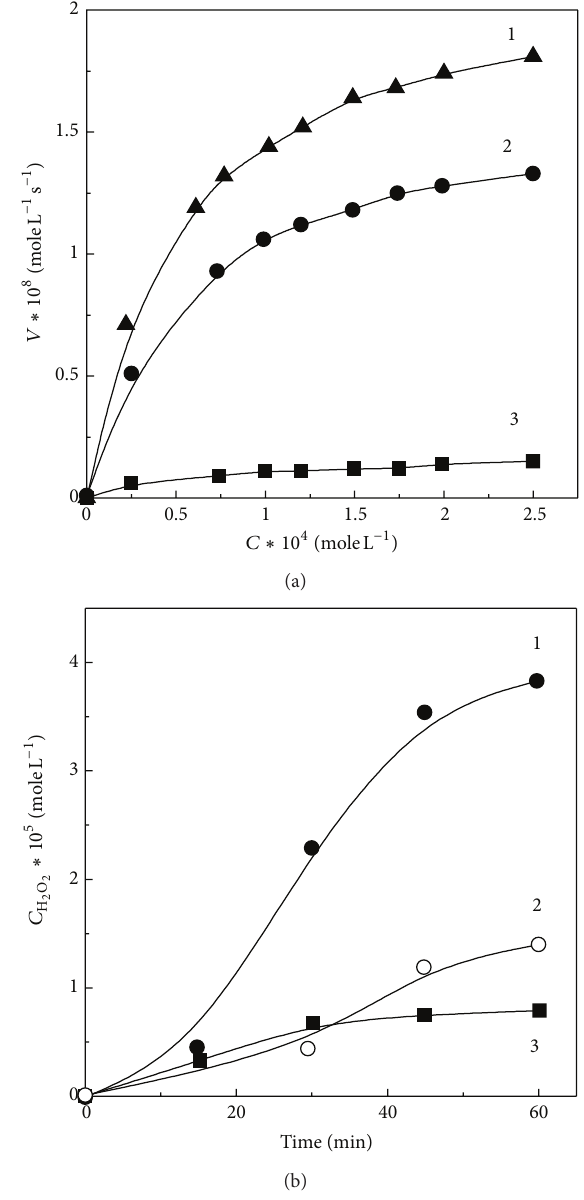
Figure 5: Thedependence oftheinitialvelocity ( 𝑉 )ofDCPAphoto- catalytic oxidation by atmospheric oxygen on initial concentration of the DCPA ( 𝐶 ) in the aqueous suspensions Fe 2 O 3 (0,5wt.%)— TiO 2 (1), TiO 2 (2), and Fe 2 O 3 (3) a composite system based on in water (pH 4.5) (a); photo generation of H 2 O 2 in aqueous suspension Fe 2 O 3 (1wt%)—TiO 2 , (1g 𝜇 M −3 ) in an oxygen atmosphere under UV light (high-pressure mercury UV lamp SVD-120, 380–400 nm) at pH: 1–6.0; 2–3.0; 3–9.0